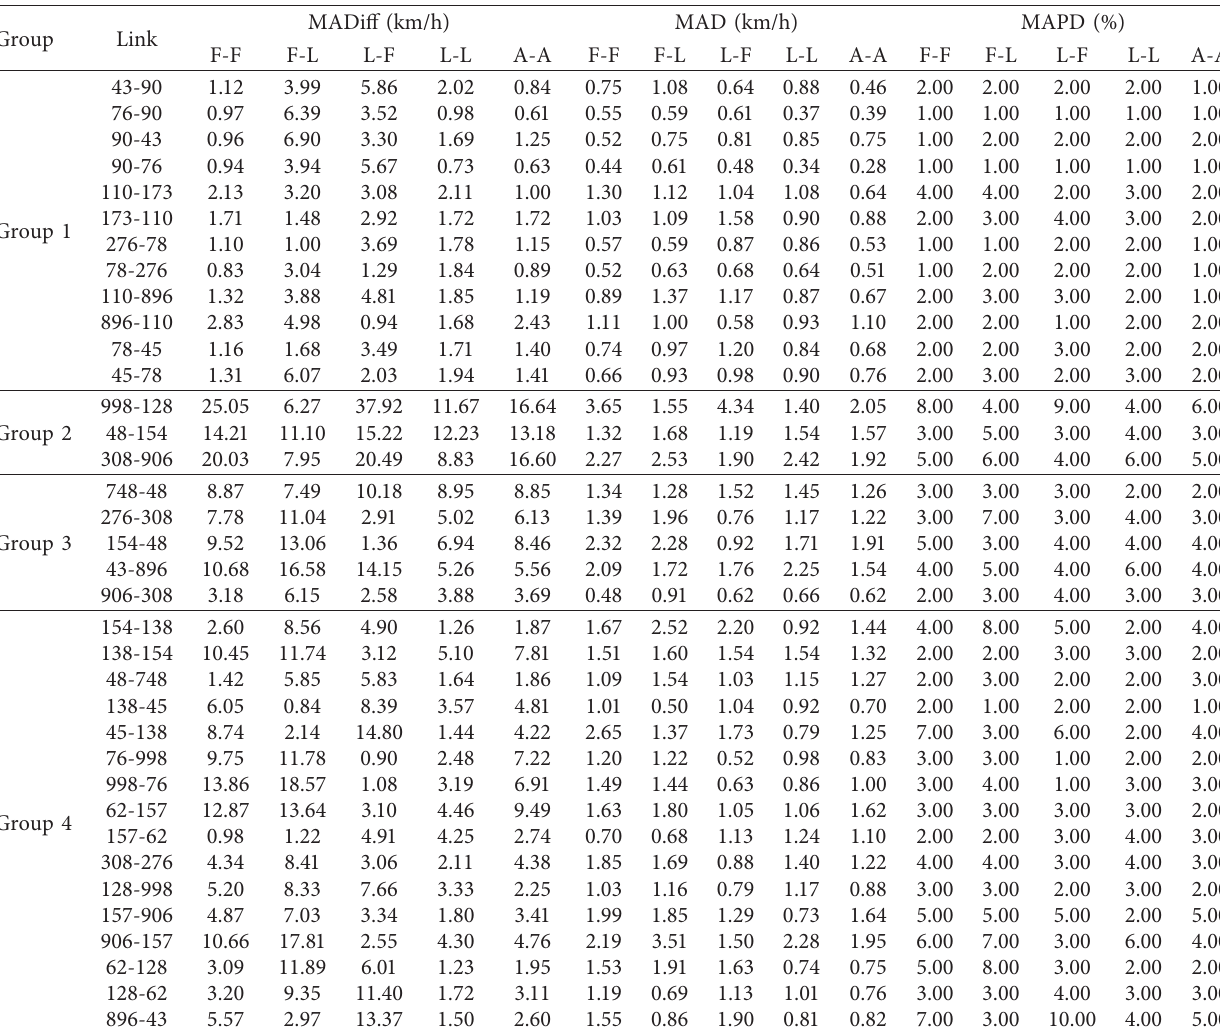
Table 5: The MADiff, MAD, and MAPD of all BT links of Canning Hwy. Group